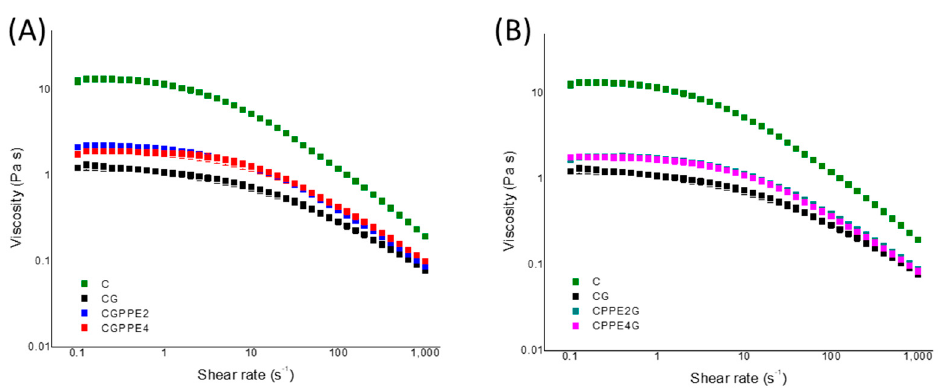
Figure 4. Viscosity curves as a function of the shear rate (0.1 to 1000 s − 1 ) at 25 ◦ C for: ( A ) C, CG, CGPPE2, and CGPPE4; and ( B ) C, CG, CPPE2G, and CPPE4G.